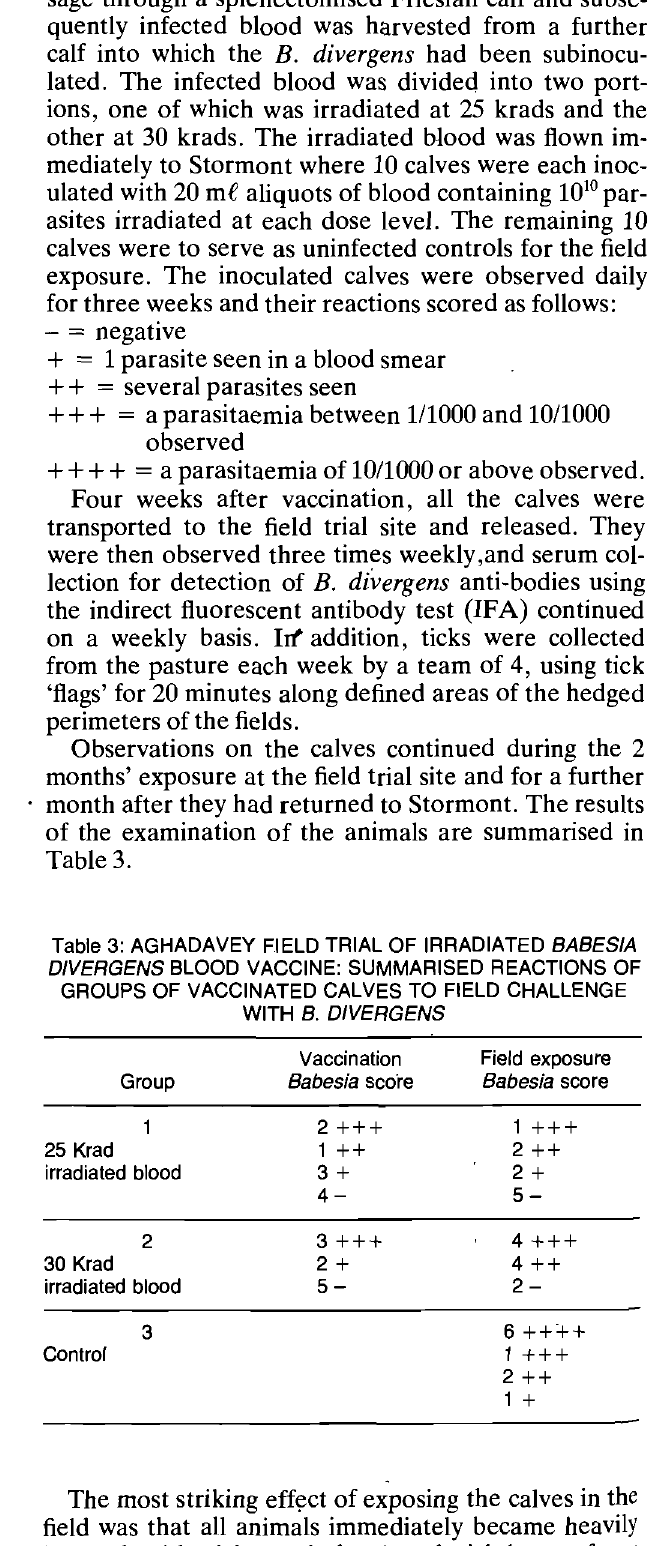
Table 2: REACTIONS OF GROUPS OF 3 INTACT CALVES TO THE INOCULATION OF IRRADIATED B. DIVERGENS- INFECTED BLOOD AND TO SUBSEQUENT CHALLENGE WITH A HETEROLOGOUS STRAIN OF B. DIVERGENS Summarised